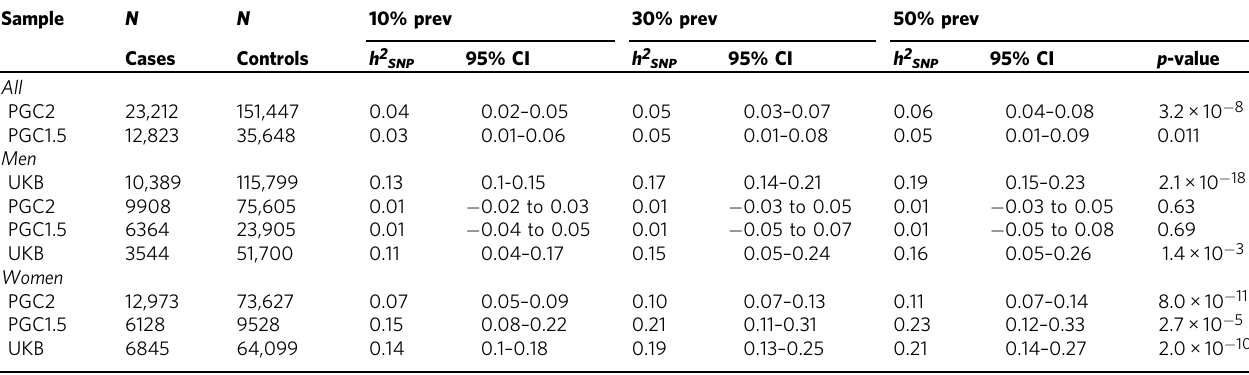
Table 1 Heritability estimates in subjects of European ancestry